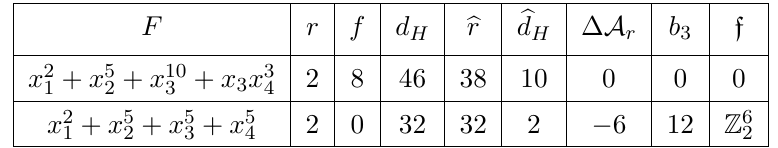
Table 4 . The isolated singularities studied in subsections 3.2 and 3.3,